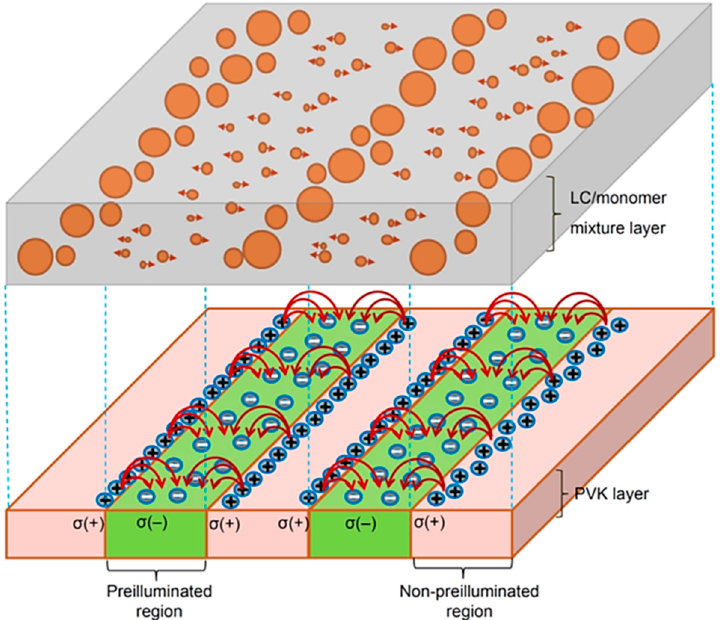
Figure 5. Model to explain the DEP-like phenomenon at constant- T R step. The non-uniform internal electric field has an increasing strength gradient from the pre-illuminated regions to the adjacent non- pre-illuminated regions near the borders of the two regions (the lower half part). The small LC droplets in the pre-illuminated regions uni-directionally migrate toward the adjacent non-pre- illuminated regions near the borders.